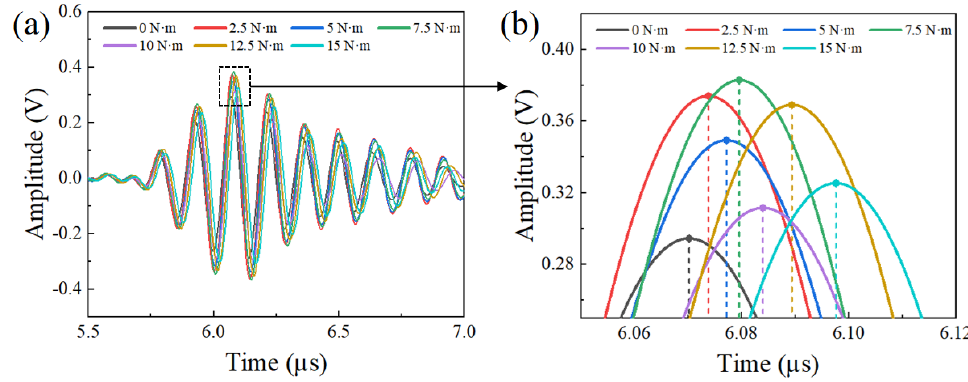
Figure 9. ( a ) Received signals from the ultrasonic sensor during different torque − tightening pro- cesses; ( b ) rectangular window demonstrating the TOF change before and after different torque tightening processes.